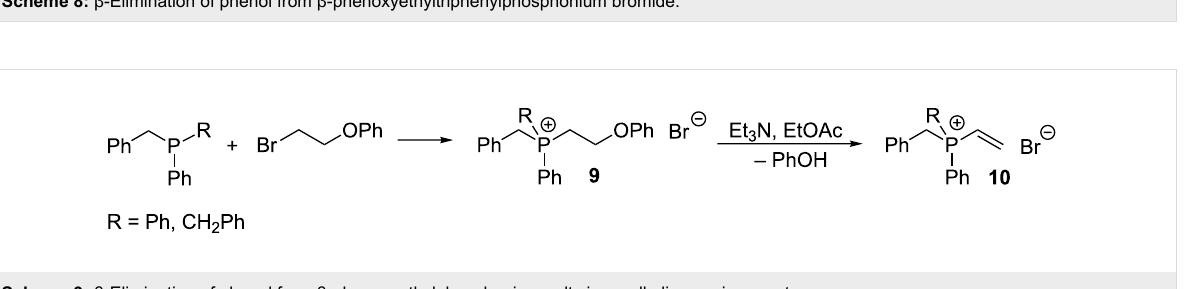
Scheme 8: β -Elimination of phenol from β -phenoxyethyltriphenylphosphonium bromide.